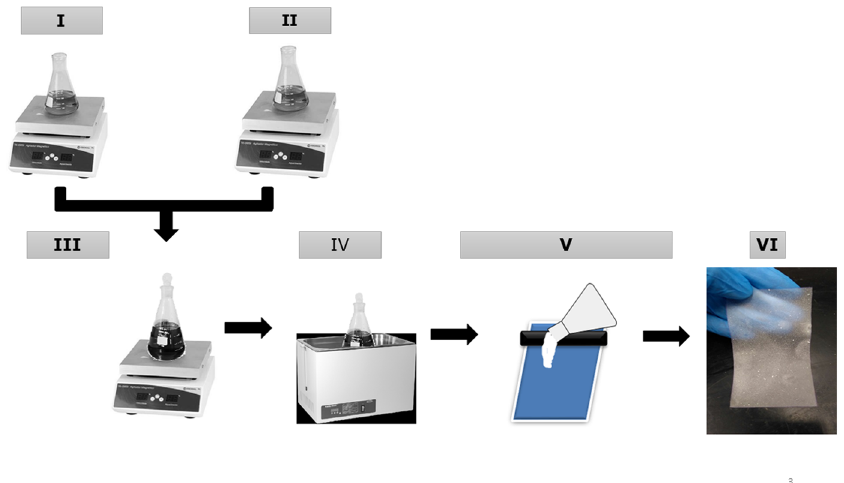
Figure 2. Preparation scheme of